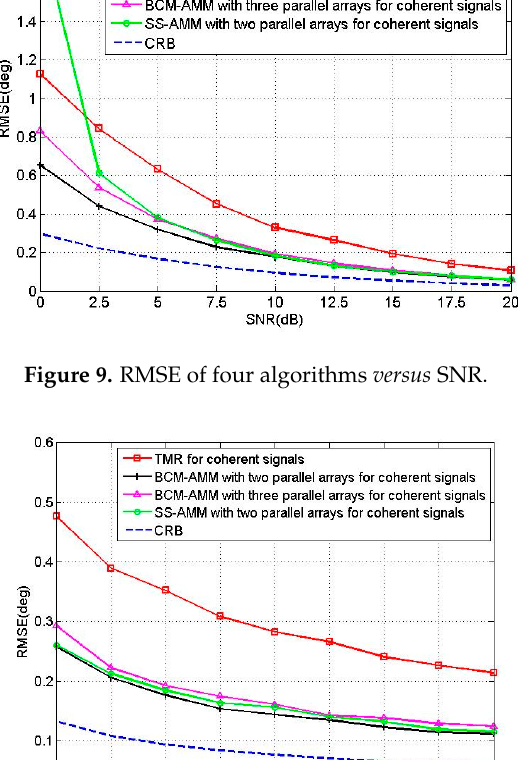
Figure 10. RMSE of four algorithms versus snapshots.